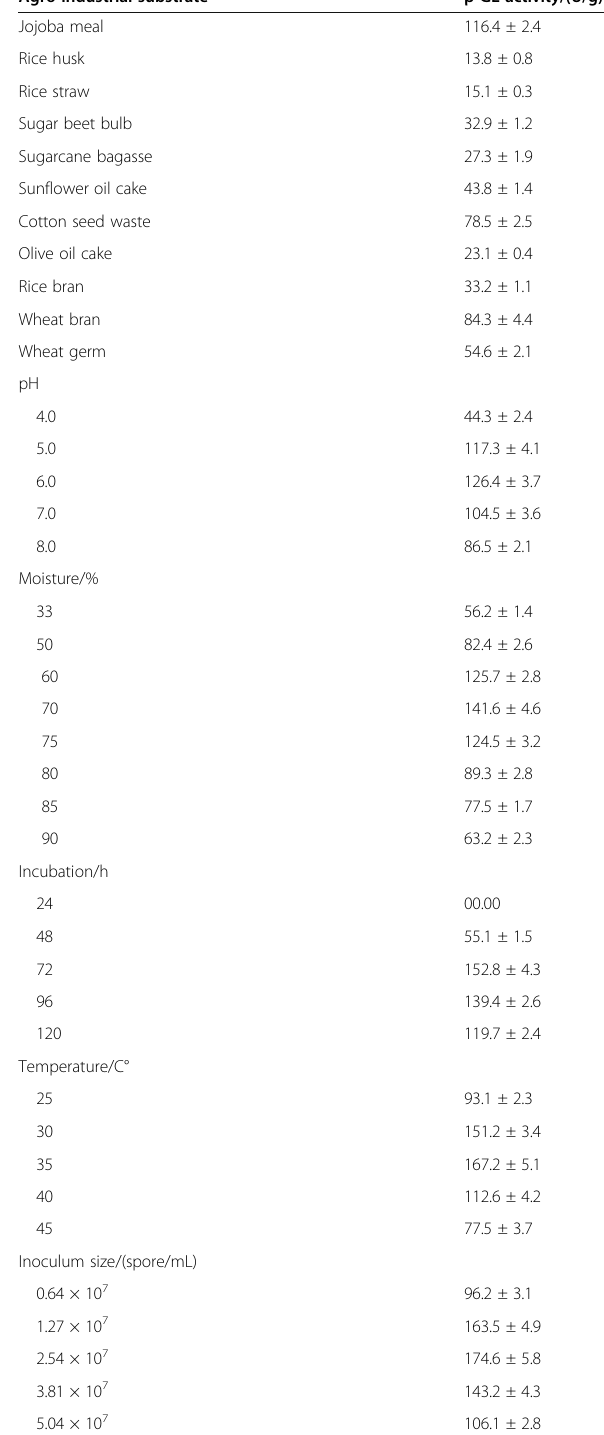
Table 2 Effect of various physicochemical parameters on extracellular β -glucosidase ( β -GL) production (on dry mass basis) by Aspergillus sp. DHE7 in solid state fermentation